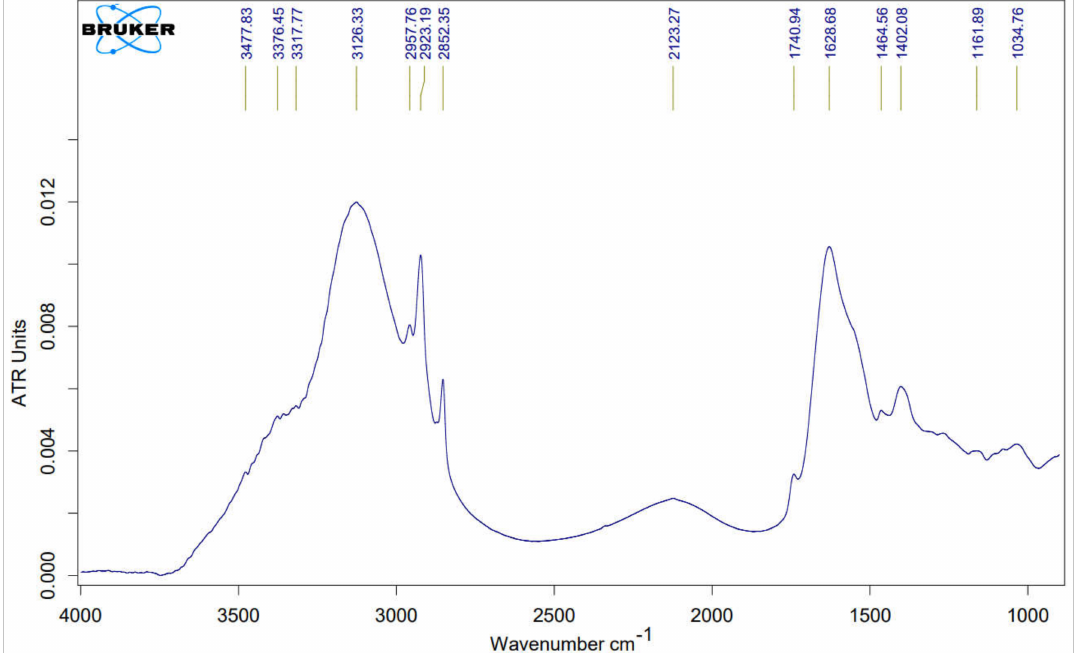
Figure 7. FTIR analysis of AuNPs at pH 10 confirmed the presence of proteins as capping